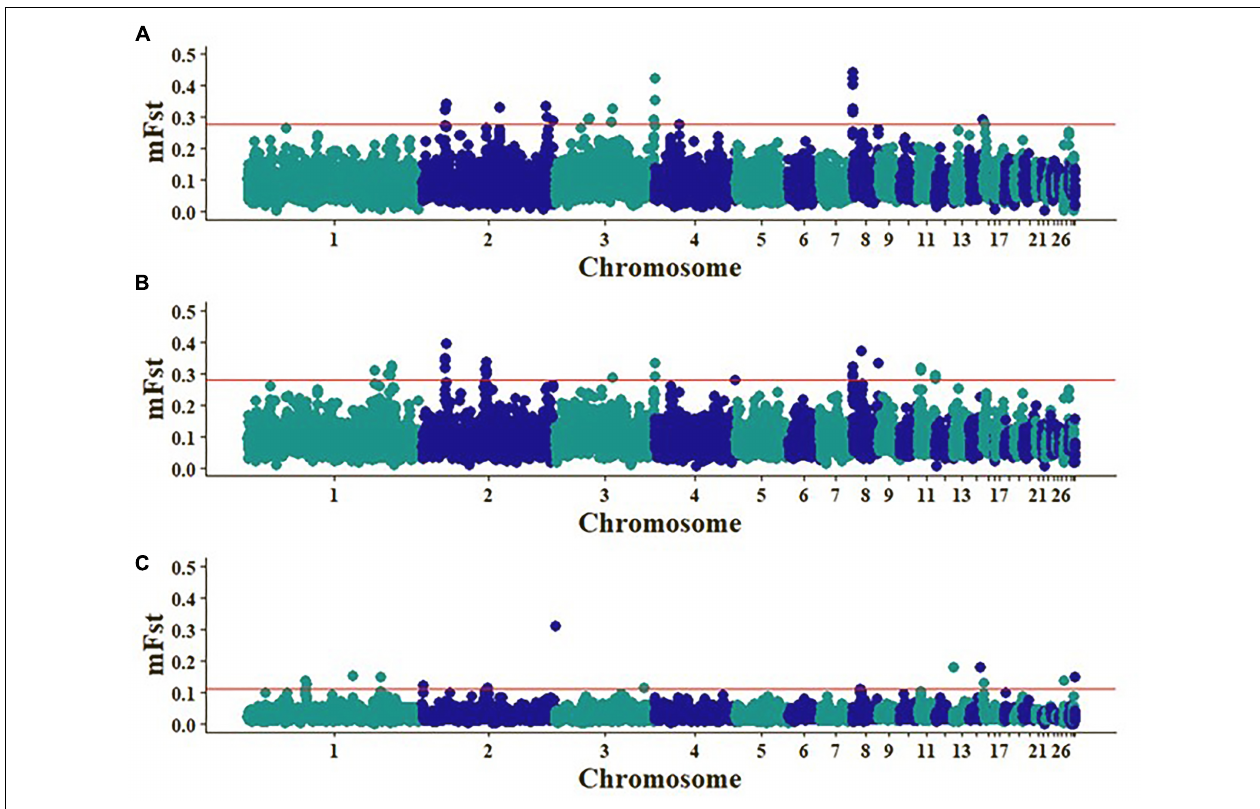
FIGURE 4 | Pairwise Fst analyses to detected regions under possible selection: Sri Lanka vs. Egypt (A) , Brazil vs. Egypt (B) , Sri Lanka vs. Brazil (C) . Red line indicates the upper 0.2% of the empirical distribution of the window mFst